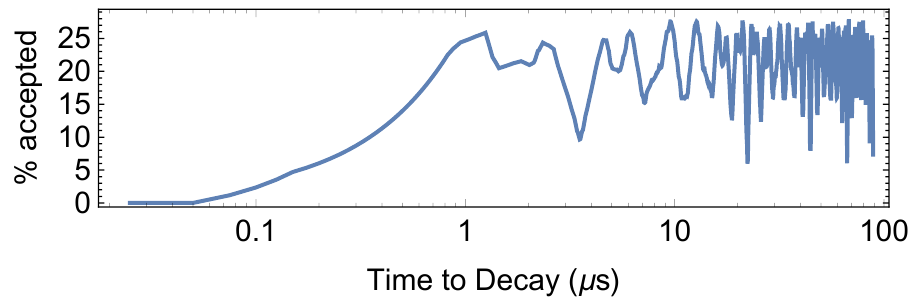
Figure 3 . The percentage of produced particles decaying at a later time t (cid:0) d=c , where d is the distance to the point of decay, that decay within a triggerable bunch window (at least two bunches away from (cid:12)lled bunch windows). For decay times > 1 (cid:22) s, the average is 21%.